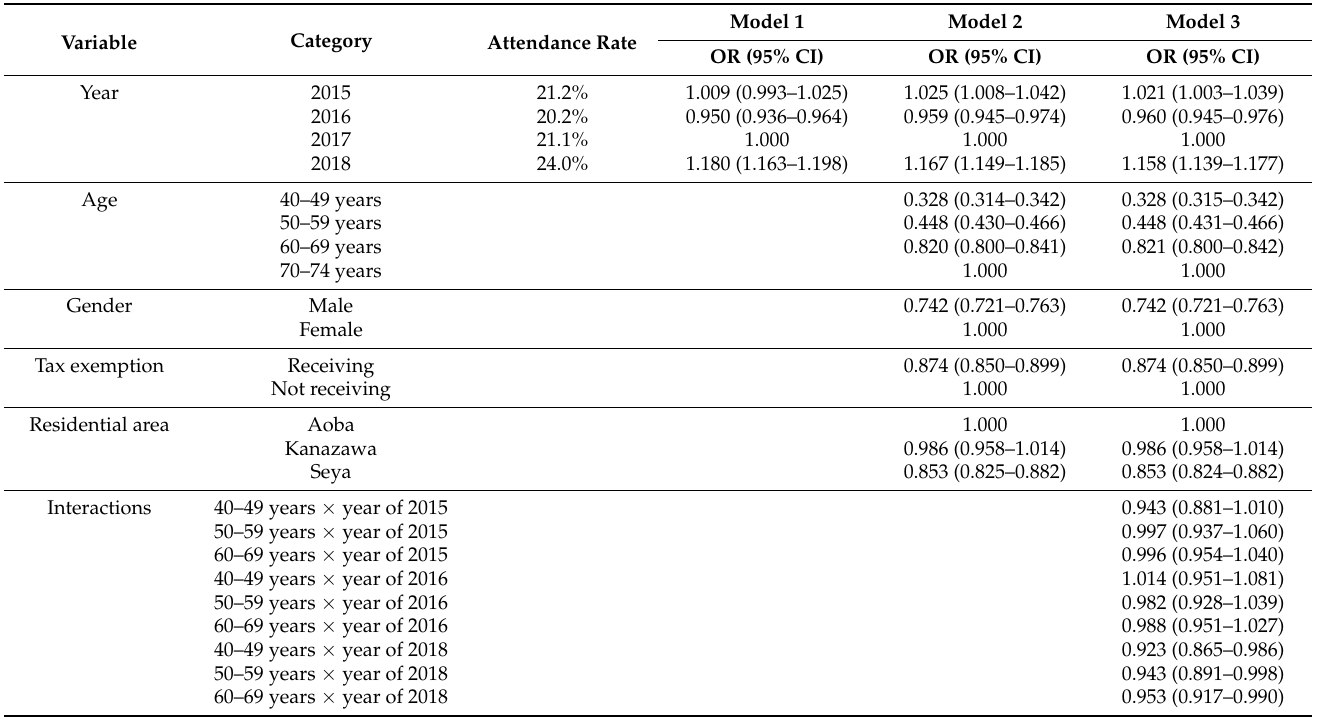
Table 3. Increases in specific health check attendance after the out-of-pocket cost removal intervention in total